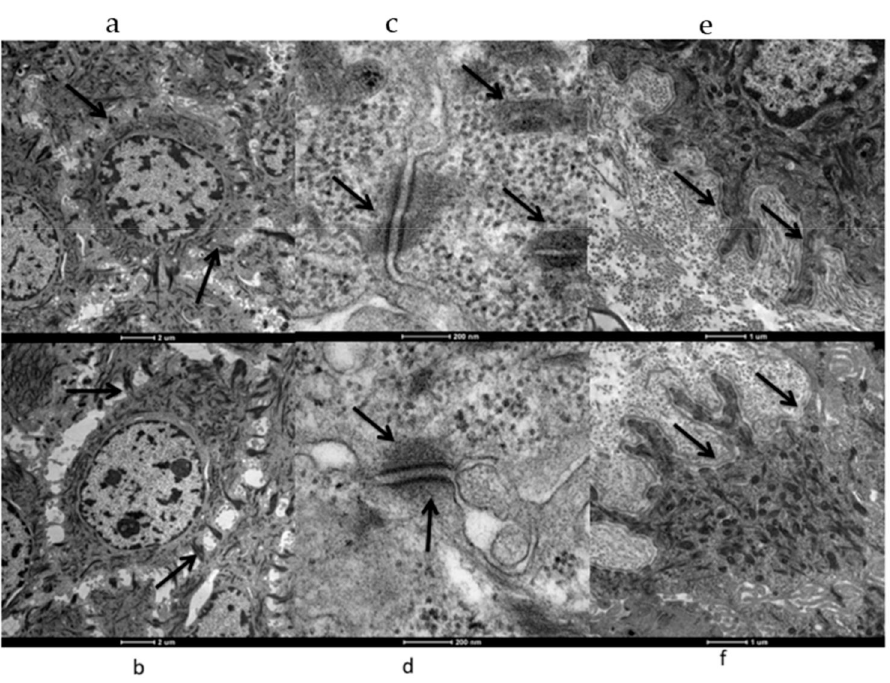
Figure 3. Transmission electron microscopy (TEM) analyses of keratinocytes interaction (black arrows a , b ), desmosomal junction (black arrows c , d ); basal lamina (black arrows e , f ) in control ( a , b , c ) and PI samples ( d , e , f ).